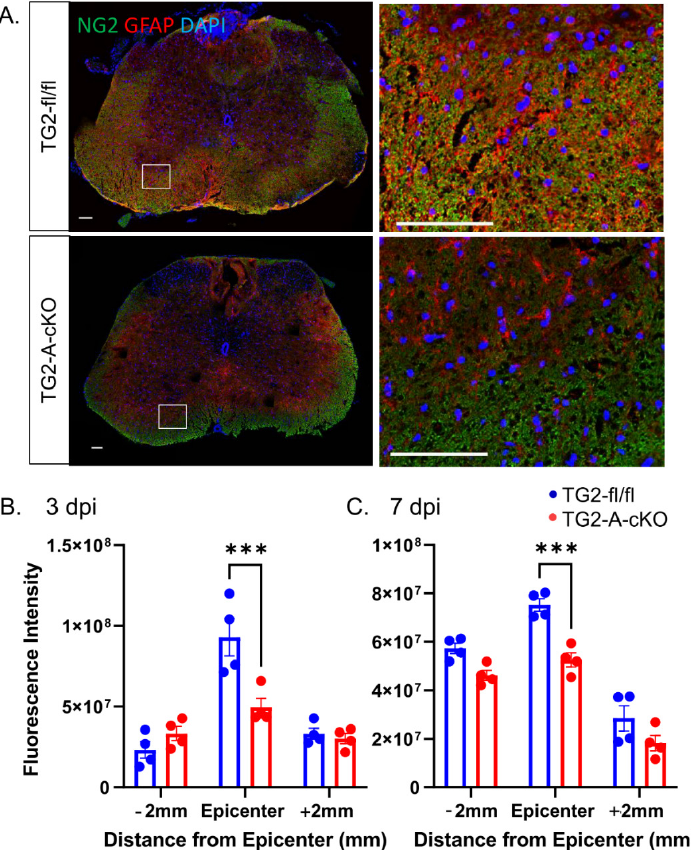
Figure 3. NG2 immunoreactivity is significantly reduced at the lesion site in TG2-A-cKO mice 3 and 7 days after spinal cord injury. ( A ) Representative images of 3 days post-injury (3 dpi) at the epicenter of the injury. Spinal cord sections were immunostained for NG2 (green), GFAP (red) and counterstained with DAPI (blue). At the right are enlargements of the boxed areas in the images at the left. Scale bars = 100 µm. ( B , C ) Quantified GFAP immunoreactivity. At 3 and 7 dpi, NG2 levels were significantly at the epicenter in the TG2-A-cKO mice. N = 4 animals per group. *** p < 0.001.